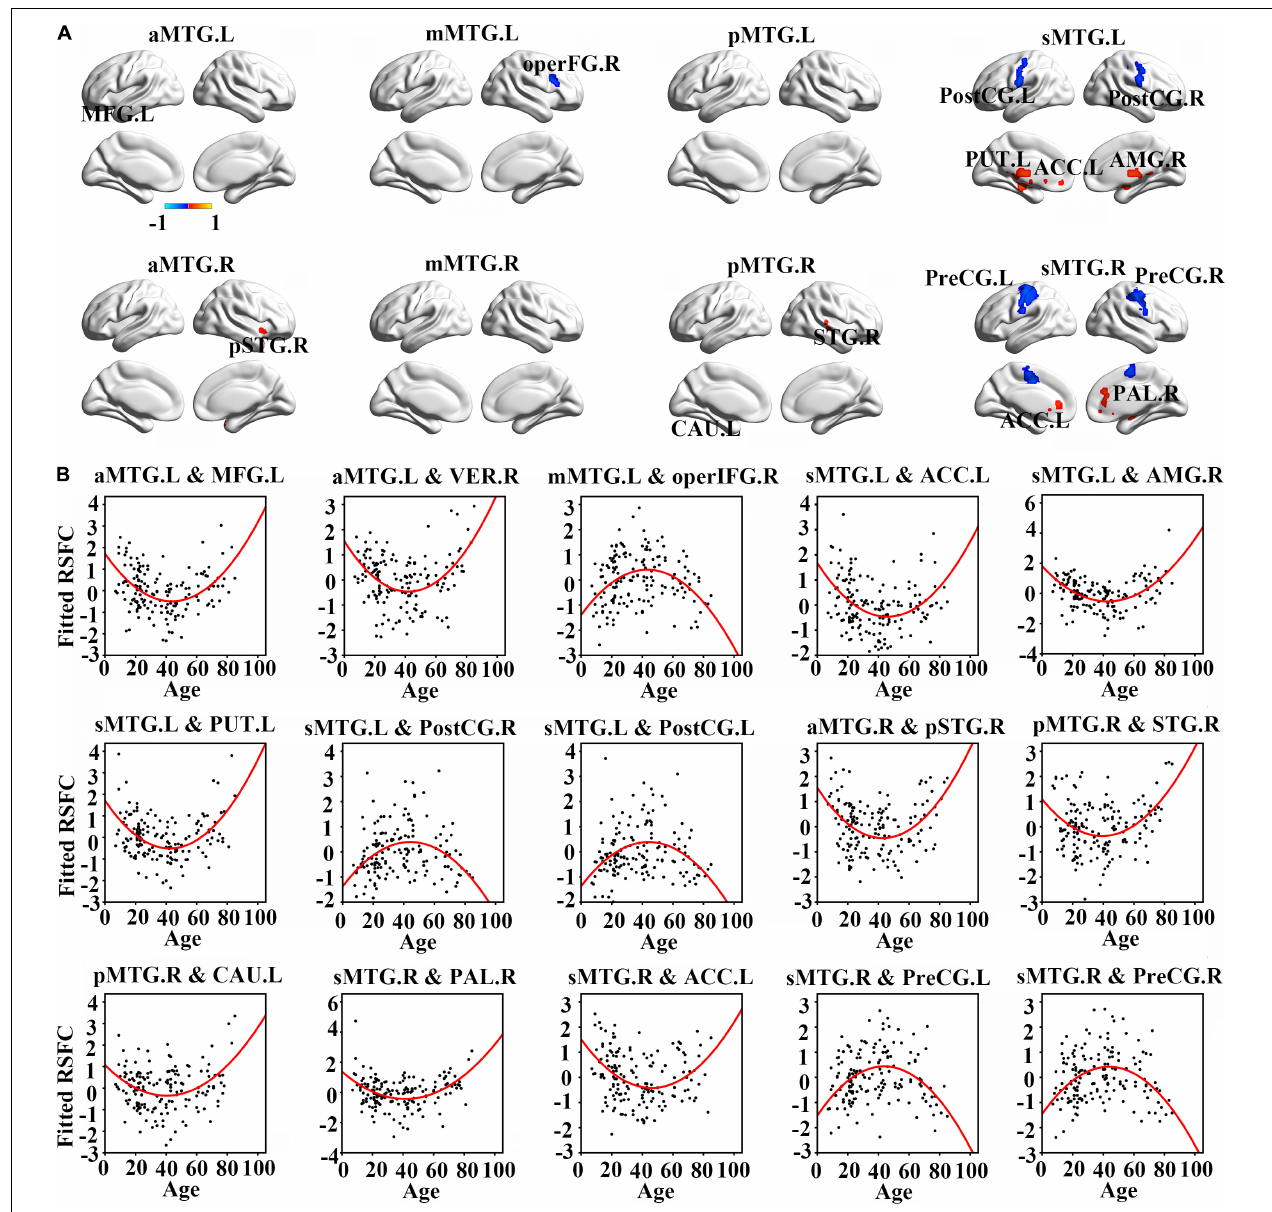
FIGURE 2 | (A) Brain regions which showed a quadratic relationship between resting-state functional connectivity (RSFC) of MTG sub-regions and age across lifespan. (B) Quadratic relationships between RSFC of MTG sub-regions and age across lifespan. Abbreviations of brain regions are listed in Table 1 .